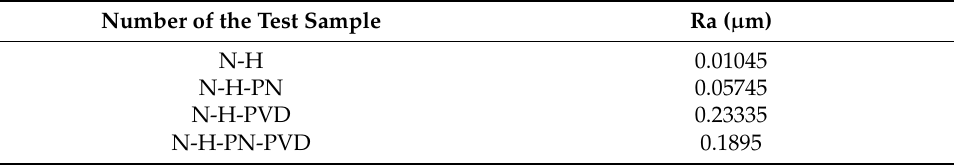
Table 4. The surface roughness of the tested samples.